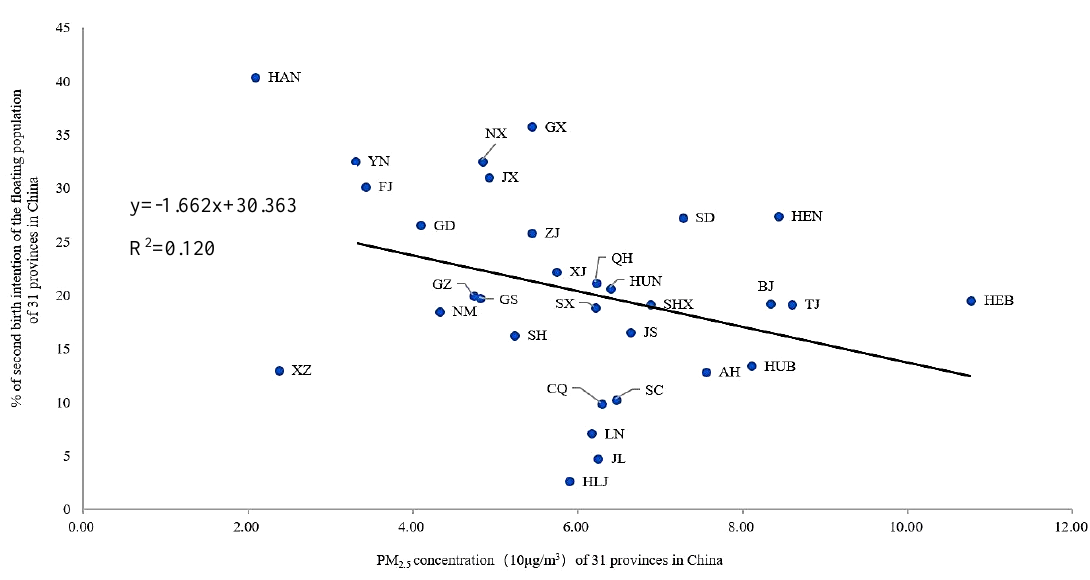
Figure 2. Predicted change in the probability of the second birth intentions of the floating population under different PM 2.5 concentration conditions.